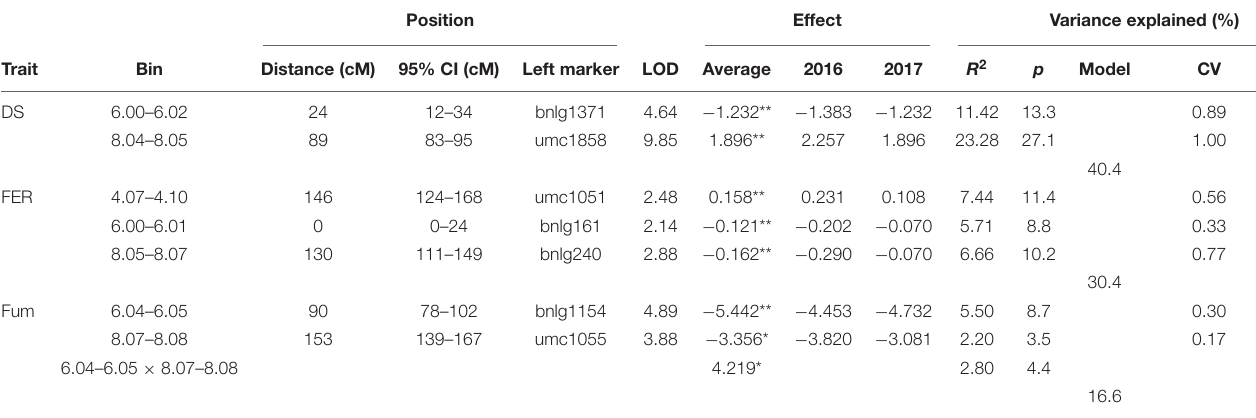
TABLE 1 | Location of quantitative trait loci (QTLs) mapped in the recombinant inbred line (RIL) population derived from EP42 × A637 for days to silking (DS), Fusarium ear rot (FER), and kernel fumonisin content (Fum) under inoculation with Fusarium verticillioides 1 . Position Effect Variance explained (%)